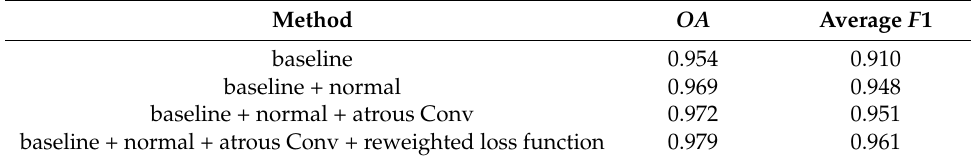
Table 4. Ablation study